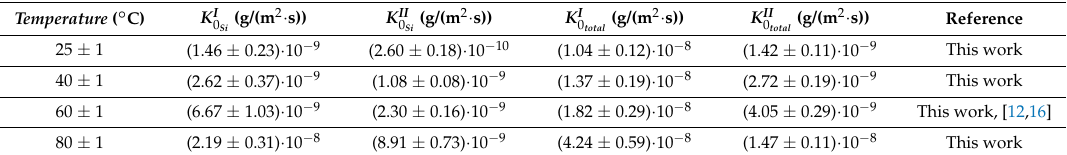
Table 2. The glass dissolution rate constants obtained via the regression of the experimental data using the Dissolving Cylinder Zero-Order Kinetic (DCZOK) model for Si and the total mass loss at a pH of 5.65 and at various temperatures. K I and II for Si and total glass dissolution, as indicated by indices.